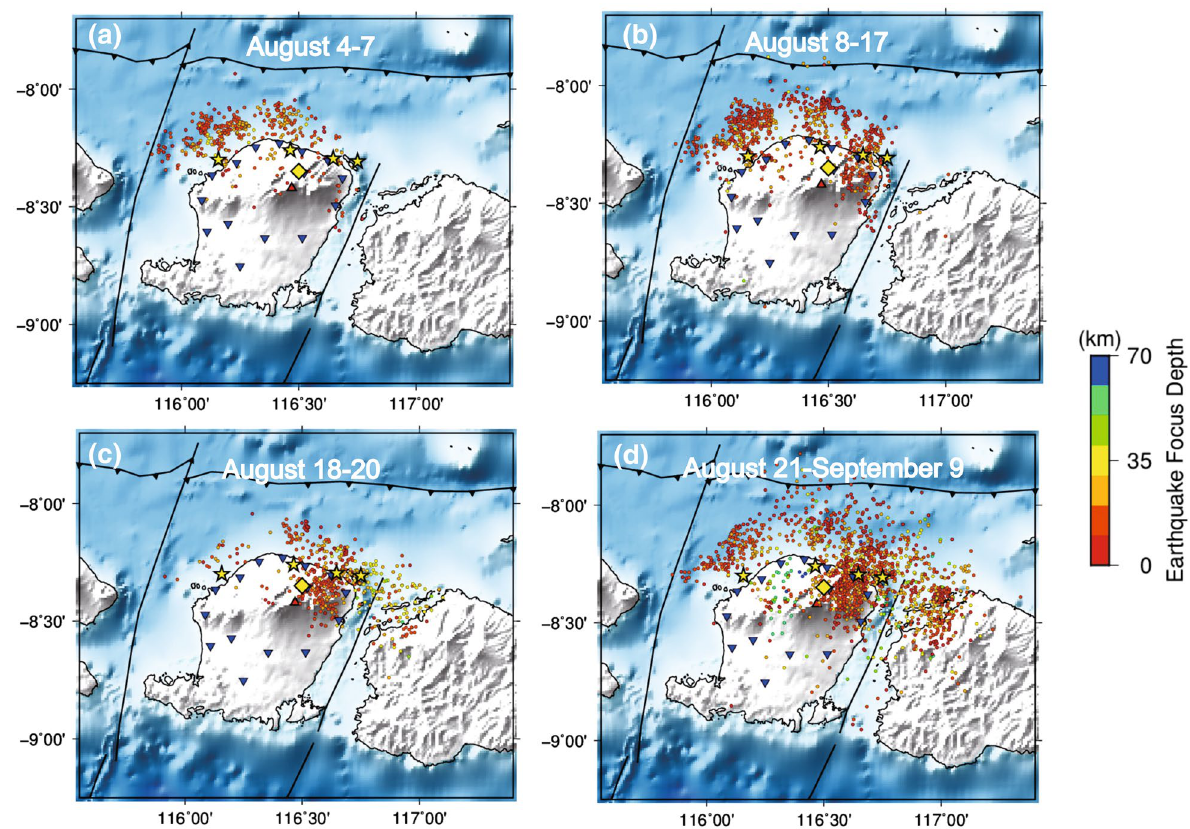
Fig. 7 Temporal variation of hypocenter location, replotted from Sasmi et al. (2020) in each time sequence shown in the white title. The inverted triangles show the location of seismometers. Red triangle shows Mt. Rinjani. The yellow diamond depicts the hypocenter of July 29 (M w 6.4) earthquake (BMKG, 2019). The yellow stars represent the significant earthquake of August 5 (M w 7.0), August 9 (M w 5.9), and 19 (M w 6.3 and 6.9) determined by Sasmi et al.